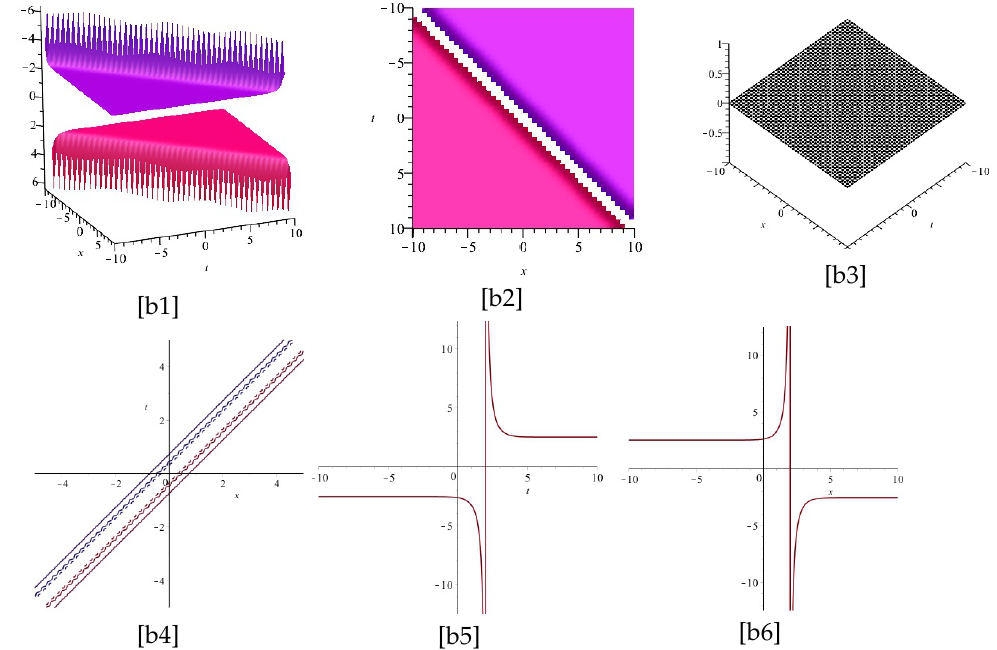
Figure 2. The plots of Equation (30), for λη < 0 and α = 1. Now, [b1] and [b3] are the imaginary and real parts of Equation (30), and [b2], [b4], [b5], and [b6] display the z -axis orientation, the contour plot, the 2d for x = 2, and the 2d for t = 2, of the imaginary part of [b1],